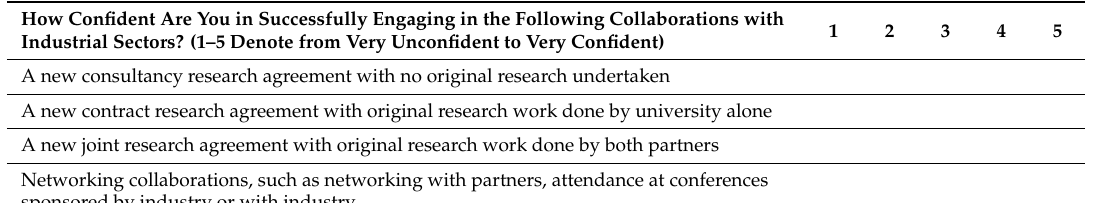
Table A1. Scale of scientists’ self-efficacy in industrial engagement